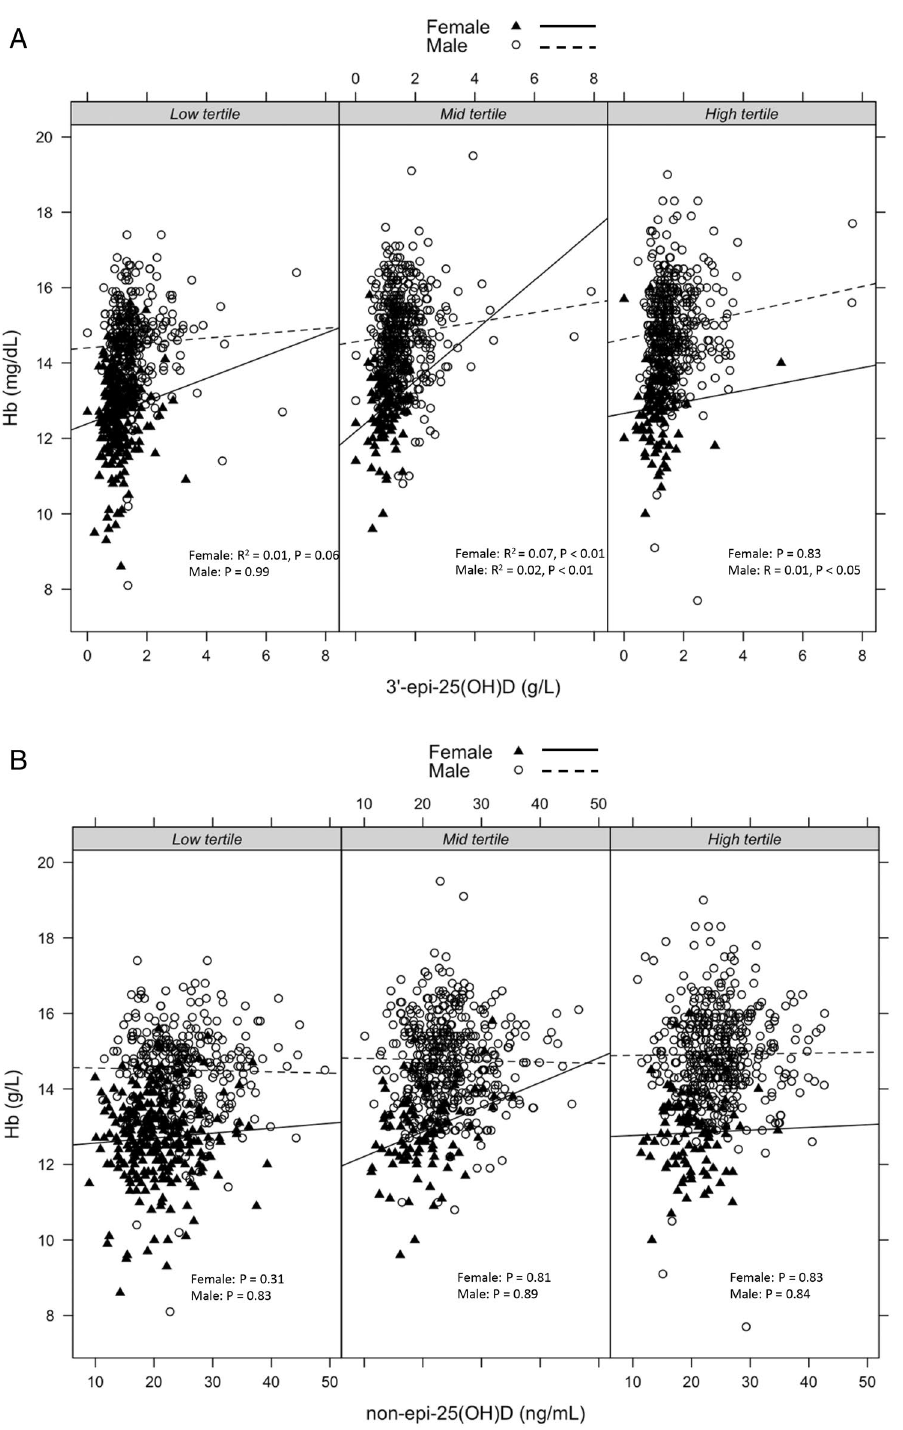
Figure 1. ( A ) Relationship between 3’-epi-25(OH)D and Hb levels according sex and BMI tertiles. 3’-epi- 25(OH)D levels in either males or females were significantly related to Hb levels in all BMI tertiles. ( B ) Relationship between Hb and non-3’-epi-25(OH)D levels according sex and BMI tertiles. There was no significant relationship between non-epi-25(OH)D levels and Hb